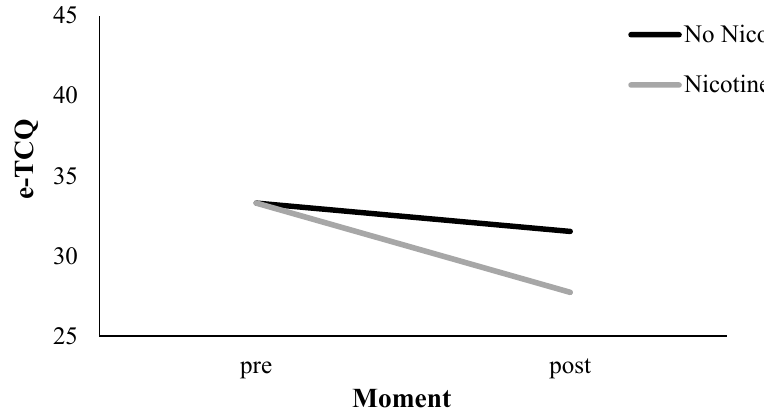
Figure 6. E-cig craving (e-TCQ) pre and post vaping: effect of nicotine level.